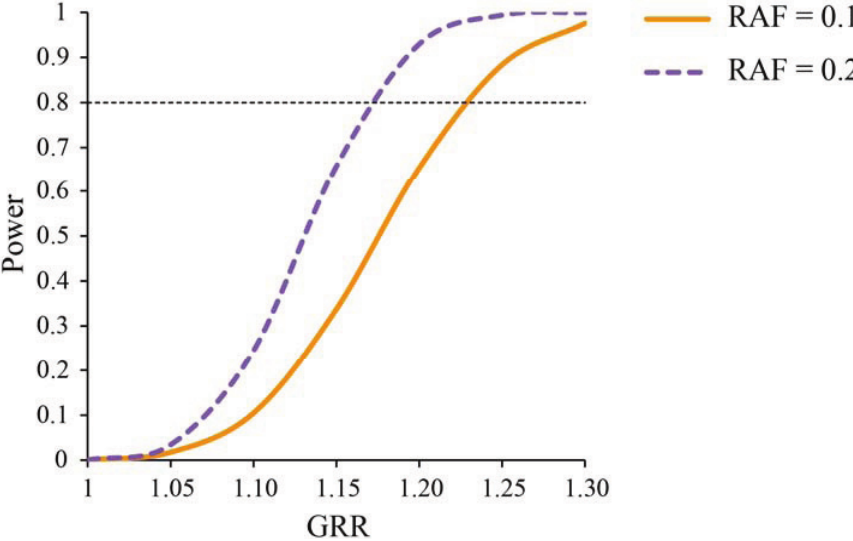
Figure 1. Statistical power to detect gene sets in the Psychiatric Genomics Consortium (PGC) Attention Deficit/Hyperactivity Disorder (ADHD) sample. Power is displayed for different genotype relative risks (GRR), and risk allele frequencies (RAF) of 0.1 and 0.2. The weighted mean of the noncentrality parameters of the case-control sample (896 cases and 2455 controls) and trio sample (2064 trios) was used to calculate power.